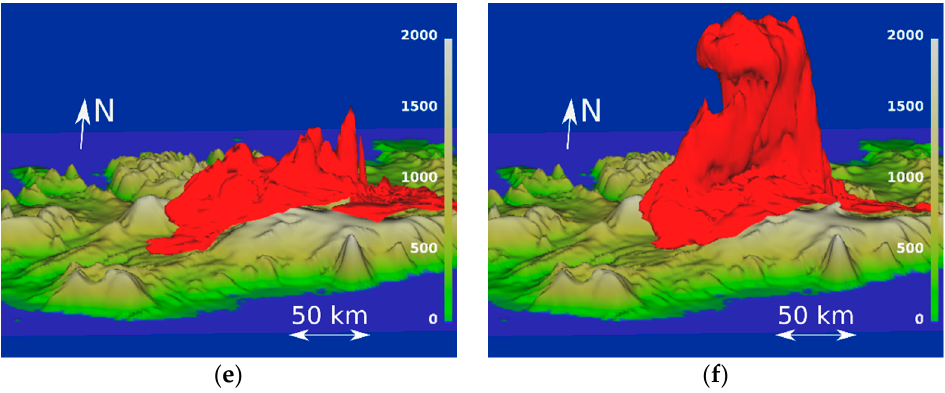
Figure 13. Visualisation of the spread of SO 2 from Holuraun fissure, November 2014. The 1 g kg − 1 SO 2 mixing ratio is shown in red, for gas release rates of 200 g kg − 1 for ( a ) 20 min, ( c ) 60 min and ( e ) 120 min after eruption. ( b , d , f show the same times after eruption, but are for a release rate of 6 g kg − 1 . The viewpoint is from an elevated position looking due north, showing height above sea level (m, colour-shaded).